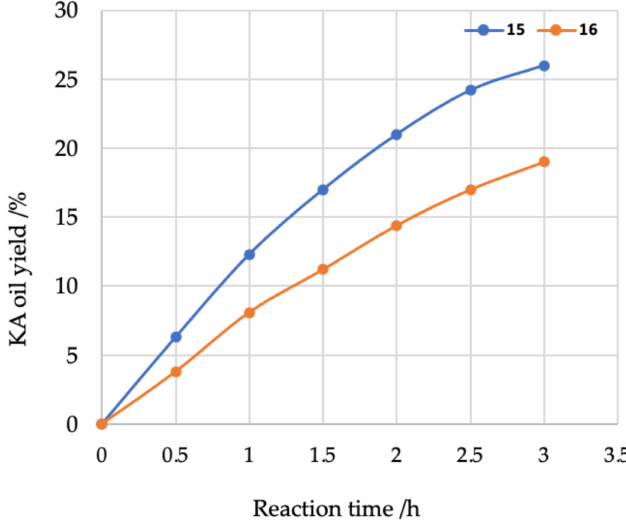
Figure 10. Effect of reaction time on the yield of KA oil obtained by microwave (MW)-assisted oxida- tion of neat cyclohexane catalyzed by complexes 15 and 16 . Reaction conditions: catalyst (5 µ mol), cyclohexane (2.5 mmol), TBHP aq. sol. 70% (5.0 mmol), temperature = 60 ◦ C. %Yield = moles of cyclohexanone + cyclohexanol per 100 mol of cyclohexane (GC yield after treatment with PPh 3